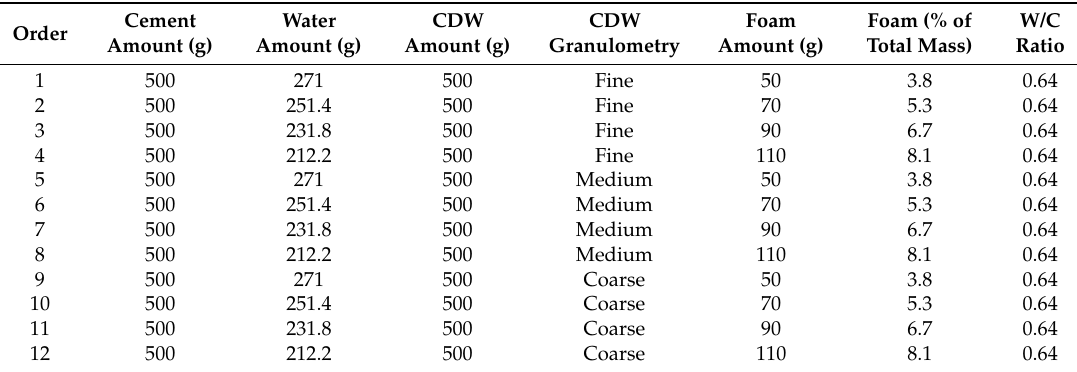
Table 1. Experimental matrix with all mixtures